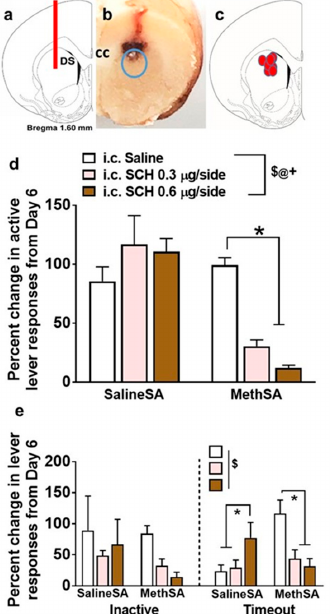
Figure 3. SCH23390 reduces methamphetamine self-administration. ( a ) Schematic of a coronal slice representing the area of the dorsomedial striatum with cannula placement for i.c. injections. ( b